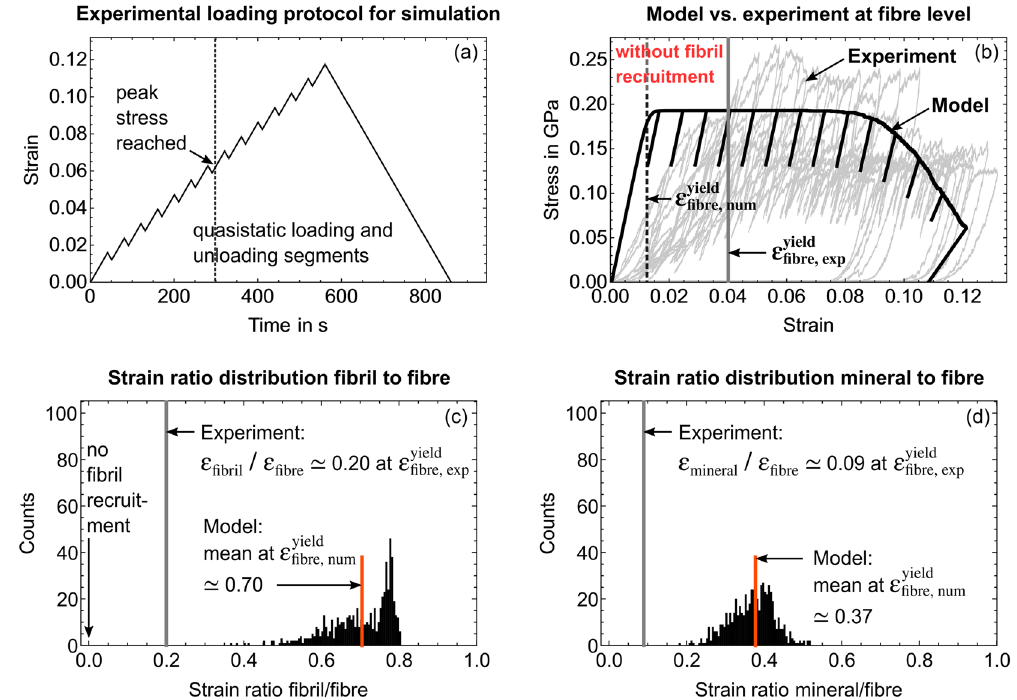
Figure 4. Model outcome for a simulated mineralised collagen fibre where we disregard non-linear fibril recruitment. Grey curves and lines represent experimental values 39 . ( a ) Experimental loading protocol. ( b ) Overlay of simulated stress-strain curve (black) and 11 experimental curves (grey) from fibre compression 39 . ( c,d ) Simulated strain ratio distributions for ( c ) fibril-to-fibre and ( d ) mineral-to-fibre at the simulated yield strain of 1.3% (black dotted line). The full loading cycle is presented in Supplementary Video